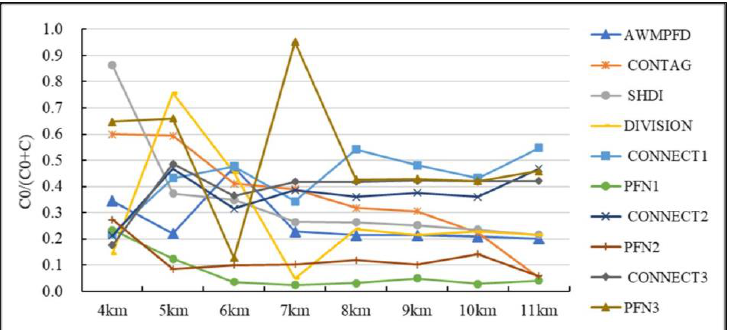
Figure 3. Characteristic values of spatial variation of landscape pattern indexs at different analytical